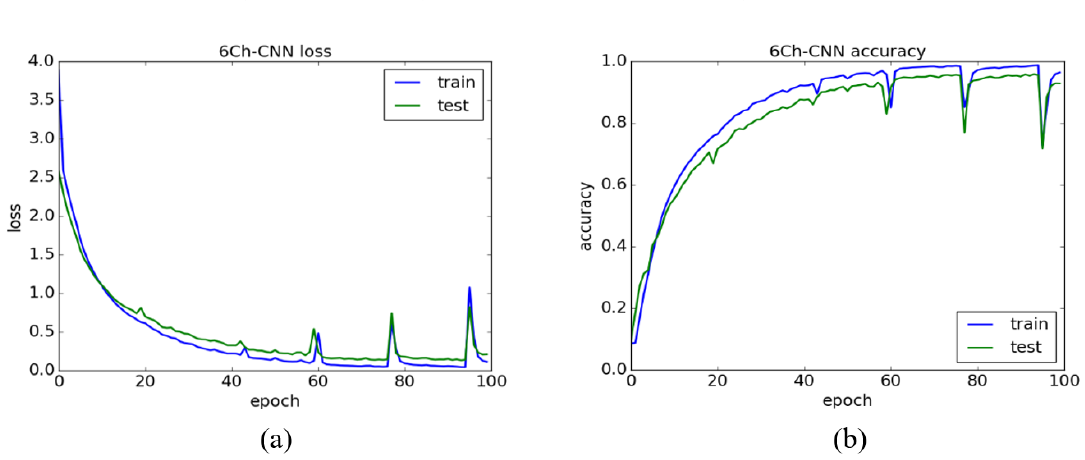
Figure 5. ( a ) Loss curve of the 6Ch-CNN; ( b ) accuracy curve of the 6Ch-CNN.